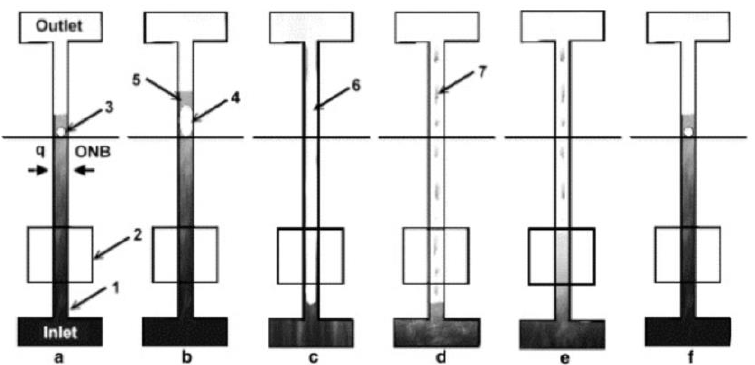
Figure 8. Scheme of explosive boiling [31]: (1) micro-channel; (2) area of visual observation; (3) onset of nucleate boiling point; (4) elongated cylindrical bubble; (5) liquid in front of the bubble; (6) vapor; (7) liquid droplets and clusters.